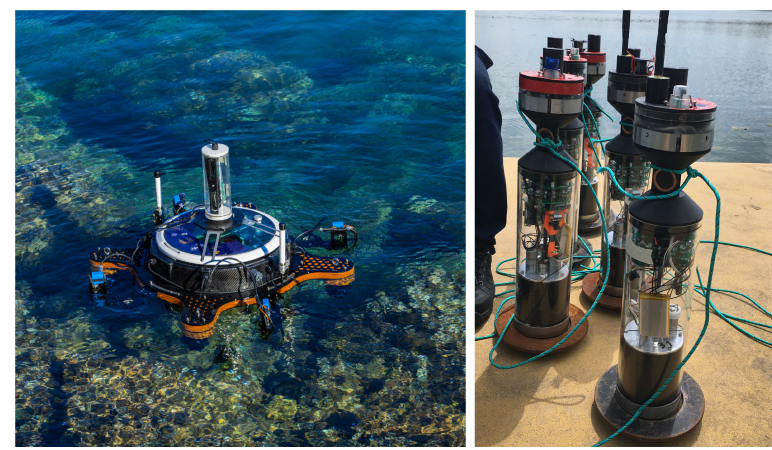
Figure 1. aPad ( left ) and aMussel ( right ) robots.